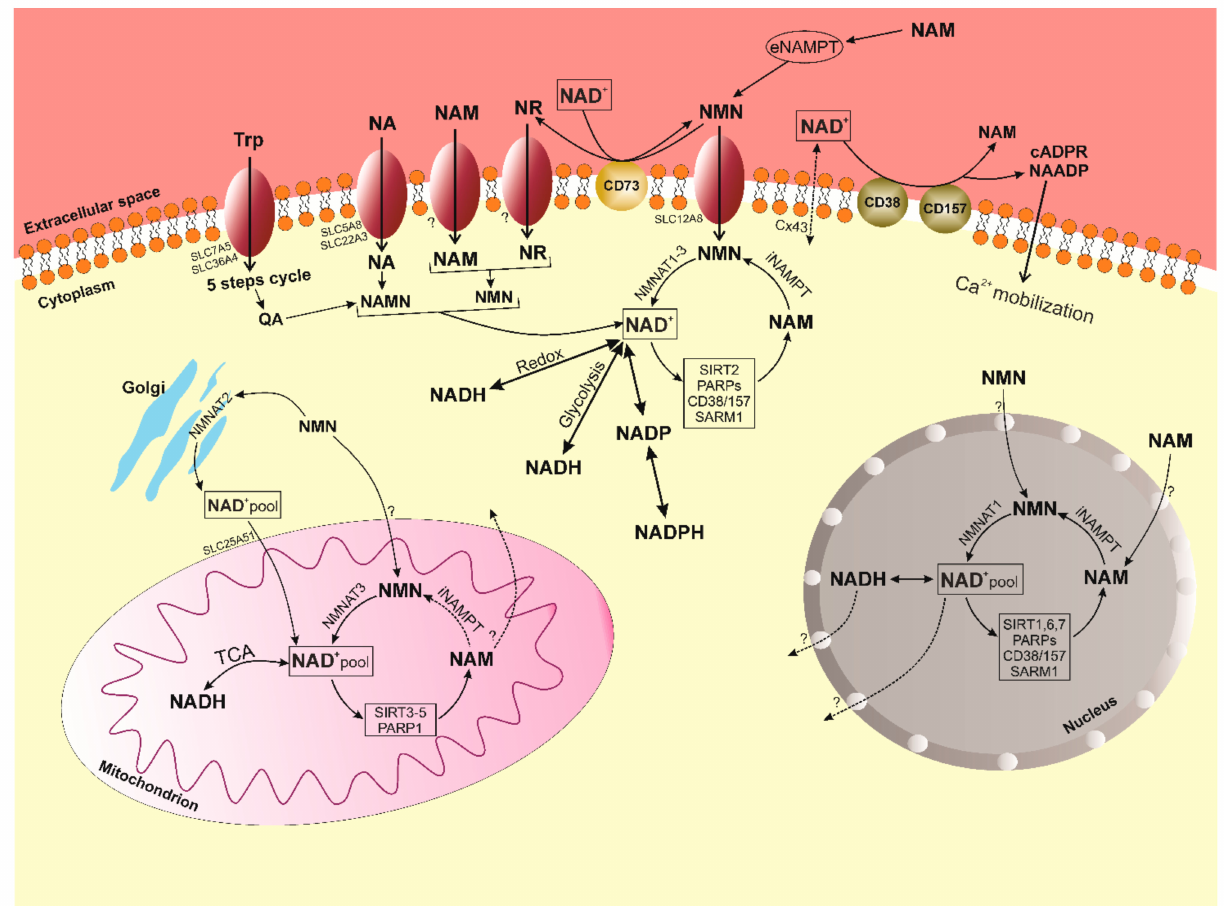
Figure 3. The balance of NAD + is the balance of synthesis, consumption and recirculation in various subcellular compart- ments (cytoplasm, nucleus and mitochondria). After entering the cell, NAD + precursors are metabolized by four main pathways (Figure 1) to NAD + . In the cytosol, nicotinamide (NAM) is converted to nicotinamide mononucleotide (NMN) by the intracellular form of NAM phosphoribosyltransferase (iNAMPT). NMN is then converted to NAD + by NMN transferase 2 (NMNAT2) bound to the outer Golgi membrane in the cytoplasm. NAD + is converted to NADH/NADPH during the redox cycle, used during aerobic/anaerobic glycolysis and is consumed by NAD-dependent enzymes (SIRT2, PARP1-3, CD38/157, SARM1). In mitochondria, NMN is converted to NAD + by NMNAT3. NAD + is used by the TCA cycle to generate ATP and is additionally used by mitochondrial sirtuins 3–5 (SIRT3-5) and PARP1, which generate NAM. Studies show the presence of NAD + , NADH and NMN transporters in the mitochondrial membrane, but no specific transporters have yet been identified [27]. It is still not clear whether NAM can be converted back to NMN within the mitochondria, or whether it is transported/diffused from the mitochondria into the cytosol [39]. Inside the nucleus, NMN is converted to NAD + by NMNAT1, while NAD + is consumed here mainly by SIRT1,6,7, PARP1-3, SARM1. As in the cytosol, NAM is returned back to the NMN by